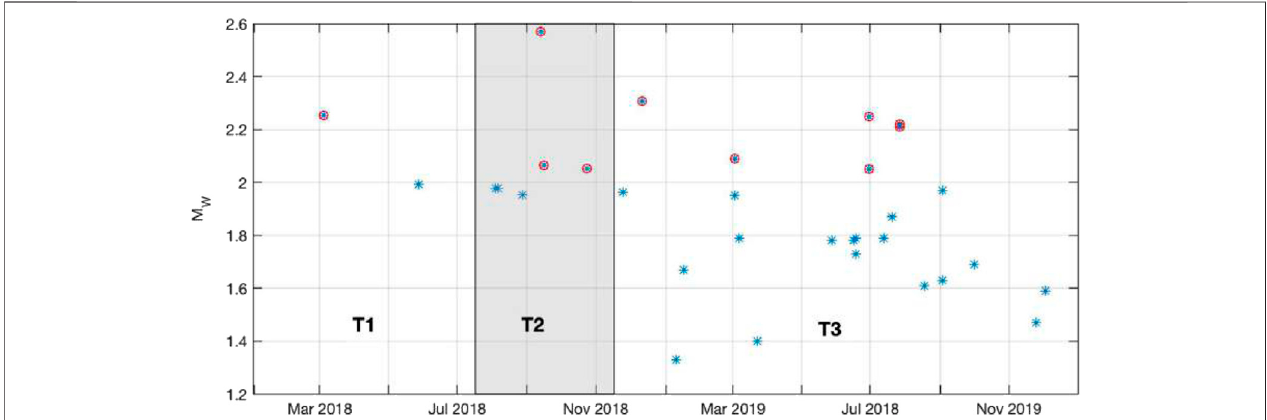
FIGURE12| Temporaloccurrenceofthe32eventsrecordedandlocatedwithintheinternalmonitoringdomainversusmagnitudes M W .Theredcirclesindicatethe 10eventsforwhich M W overcomesthecompletenessmagnitude.Theshadowedareaindicatestheindustrialactivityshutdownperiod,andthetimeperiodsT1,T2,and T3, de fi ned for testing the seismic rate variations are indicated at the